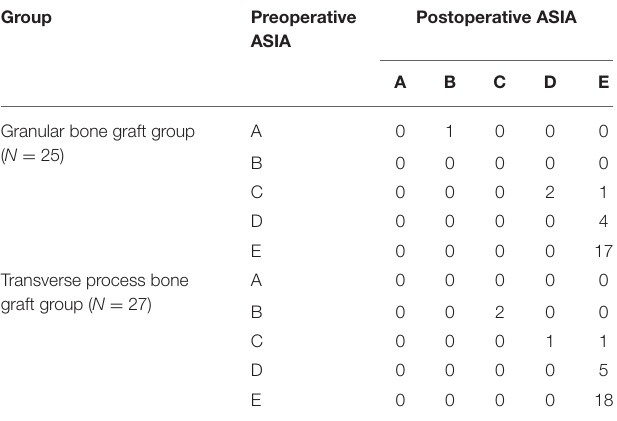
TABLE 2 | Comparison of clinical outcomes between the two groups.